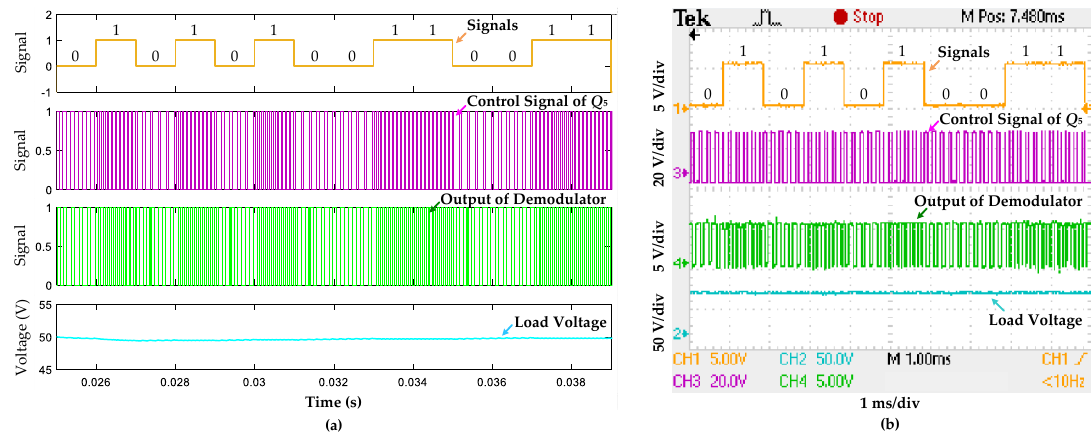
Figure 17. Data backward transmission waveforms at 1 kbit/s rate ( a ) simulation result ( b ) experimental result.